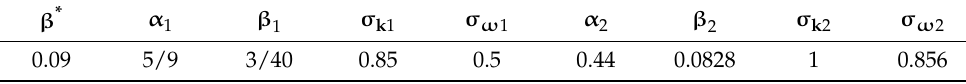
Table 1. Constant coefficients in the shear stress transport (SST) k– ω model. β